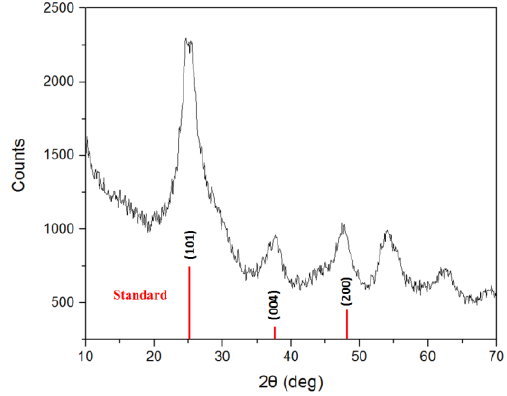
Figure 3. X-ray diffraction (XRD) pattern of Ti–O–Si-organic precursor.